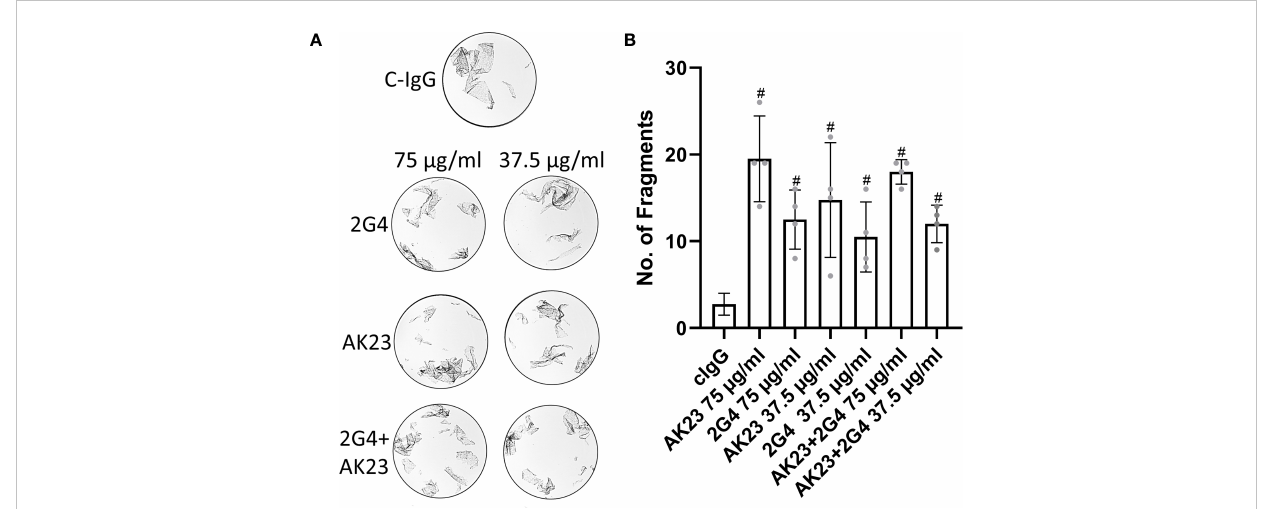
FIGURE 2 (A) Representative images of dispase-based dissociation assay results in HaCaT cells. Control, treated with C-IgG only (top), treated with either single 2G4, AK23 or a mixture of both at a concentration of 75 µg/ml eacht (left) and at half concentration of 37.5 µg/ml right. (B) Quanti fi cation of dispase-based dissociation assay (N=4). # indicates statistically signi fi cant differences towards control conditions, one-way-ANOVA with Dunett correction for multiple comparisons,